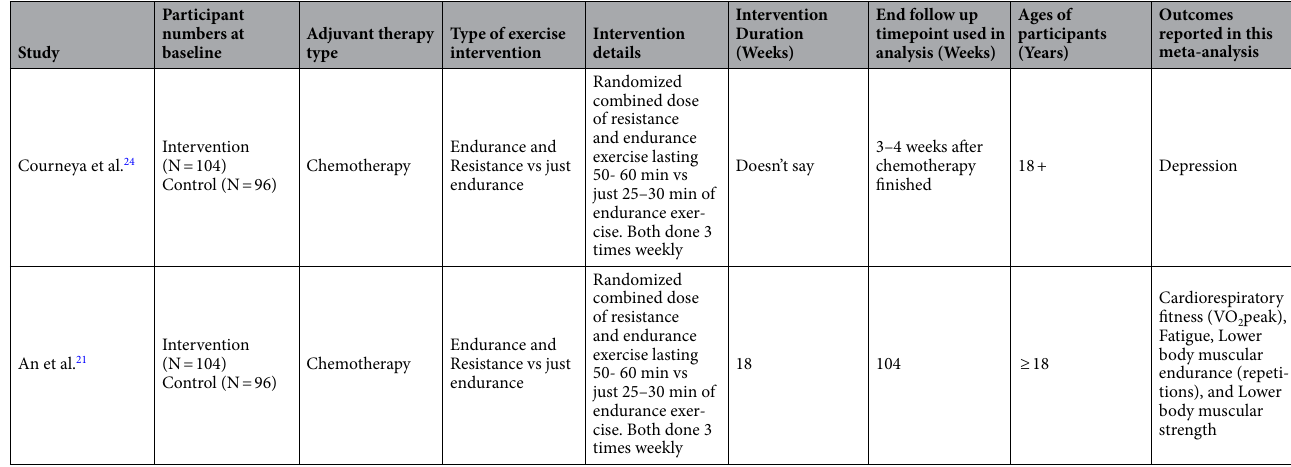
Table 2. Study characteristics for studies that were used in these meta-analyses including Participant numbers at baseline, adjuvant therapy type, type of exercise intervention used, intervention details, intervention